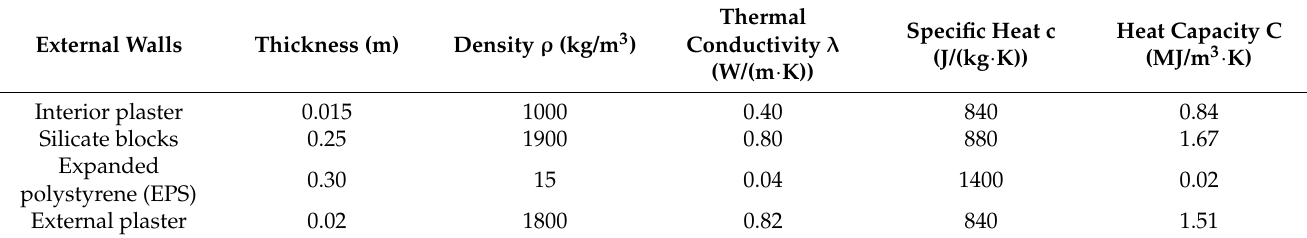
Table 1. Material properties of the external wall